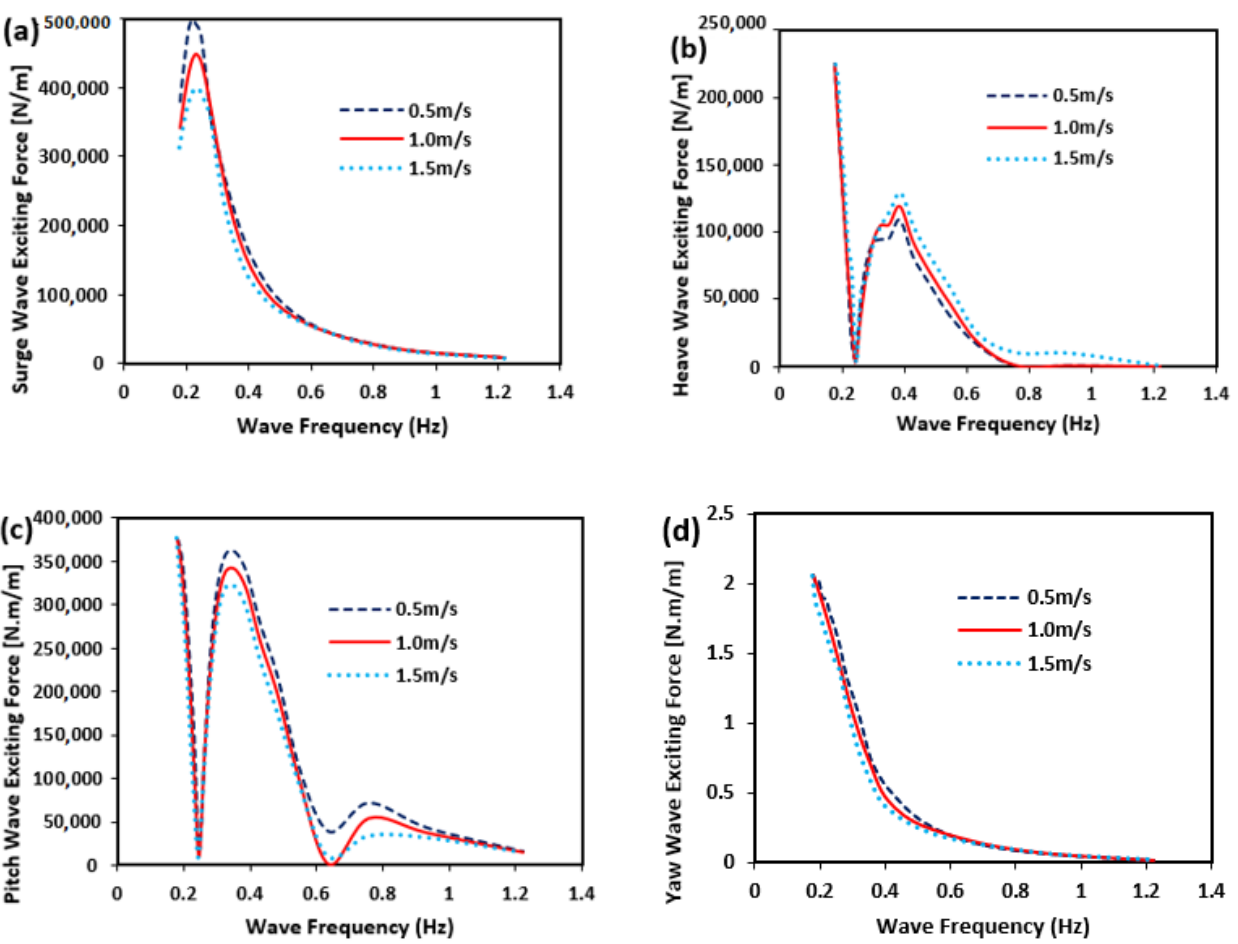
Figure 27. Influence of current velocity on the first-order forces for the CALM buoy, showing ( a ) surge, ( b ) heave, ( c ) pitch and ( d ) yaw.